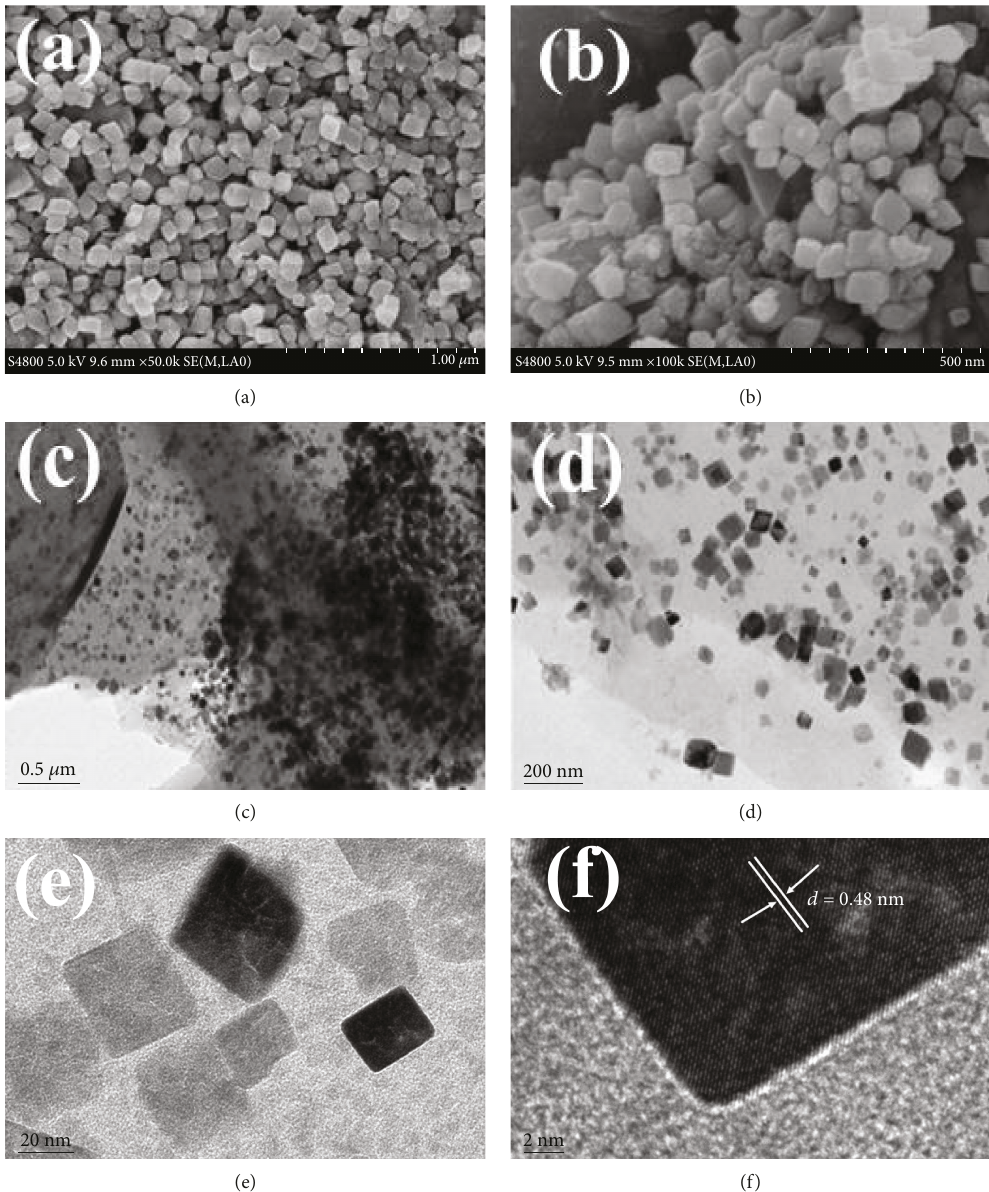
Figure 2: The SEM images of MFO (a) and MFO/rGO (b) and low-magni fi cation (c, d) and high-resolution (e, f) TEM images of